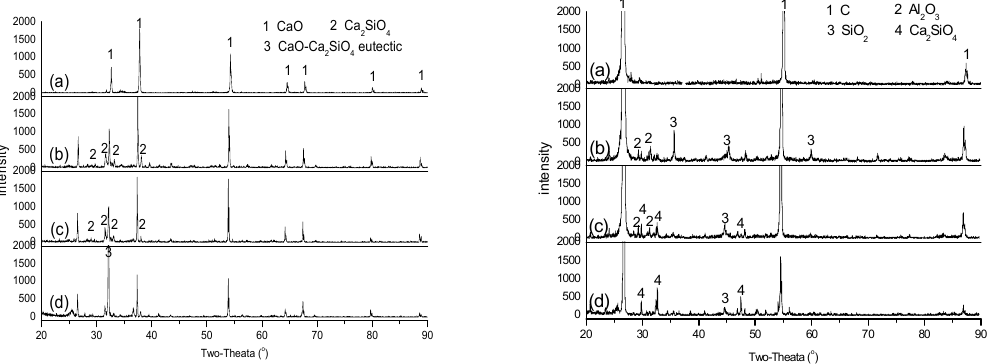
Figure 9. XRD analysis of CaO ( left ) and ash-C ( right ) after being heat treated at 1500 °C for different time: ( a ) CaO or ash-C alone; ( b ) CaO+ash-C (1 h); ( c ) CaO+ash-C (2 h); ( d ) CaO+ash-C (4 h).